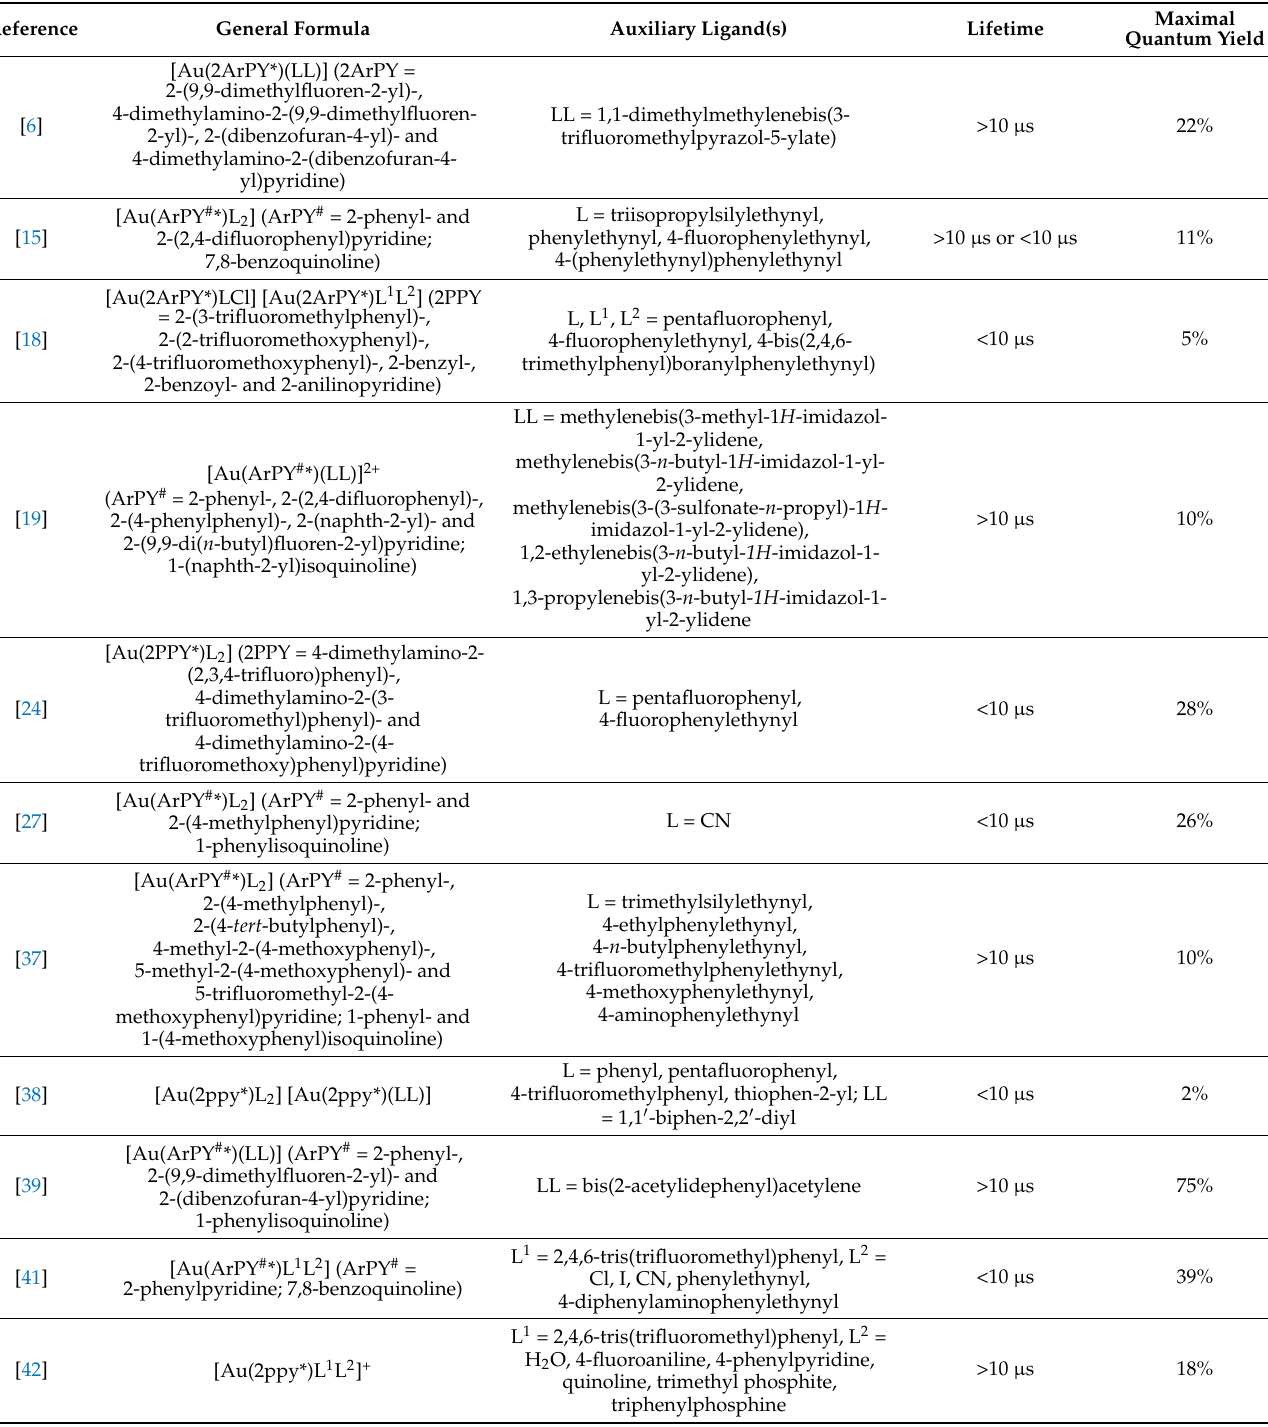
Table 12. Summary of luminescence studies for the reviewed Au(III)